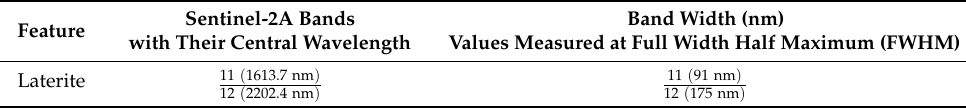
Table 1. Band ratio of Sentinel-2 used as proxy for mapping aluminum-rich minerals